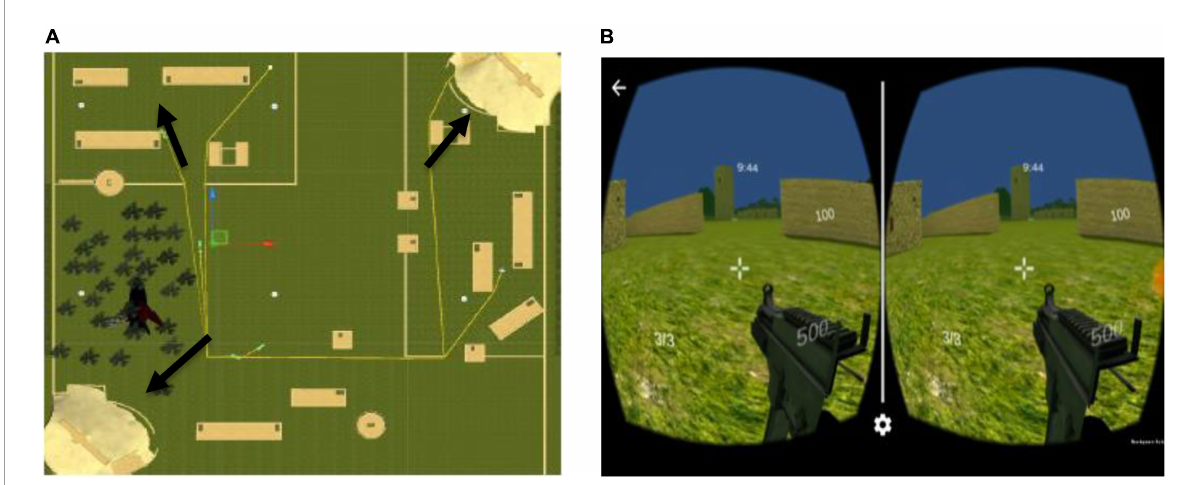
FIGURE1 (A) Overhead map of the terrain-based search-and-shoot environment designed in Unity3D. The arrows indicate the locations of the army bases sieged by the enemies. (B) The HMD VR interface, indicating the time remaining at the top, the participant’s health at the middle-right corner, the number of army bases to be required from the enemies in the bottom-left corner and the number of bullets remaining at the bottom-right corner of the interface. Reproduced with permission from Rao et al. (2020b).